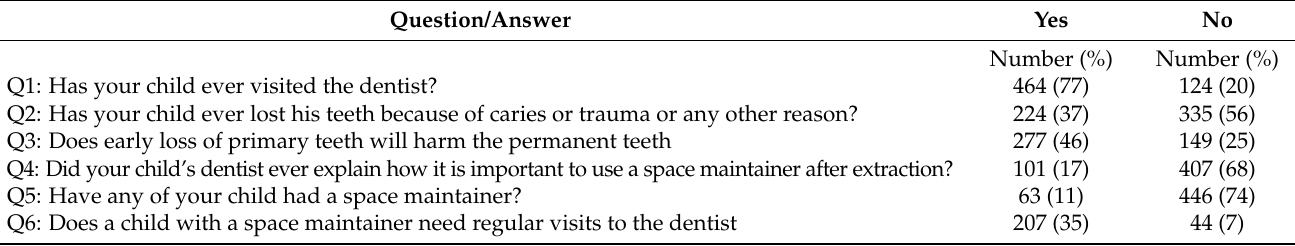
Table 2. Distribution of study participants according to responses for questions with an answering scheme of “Yes or